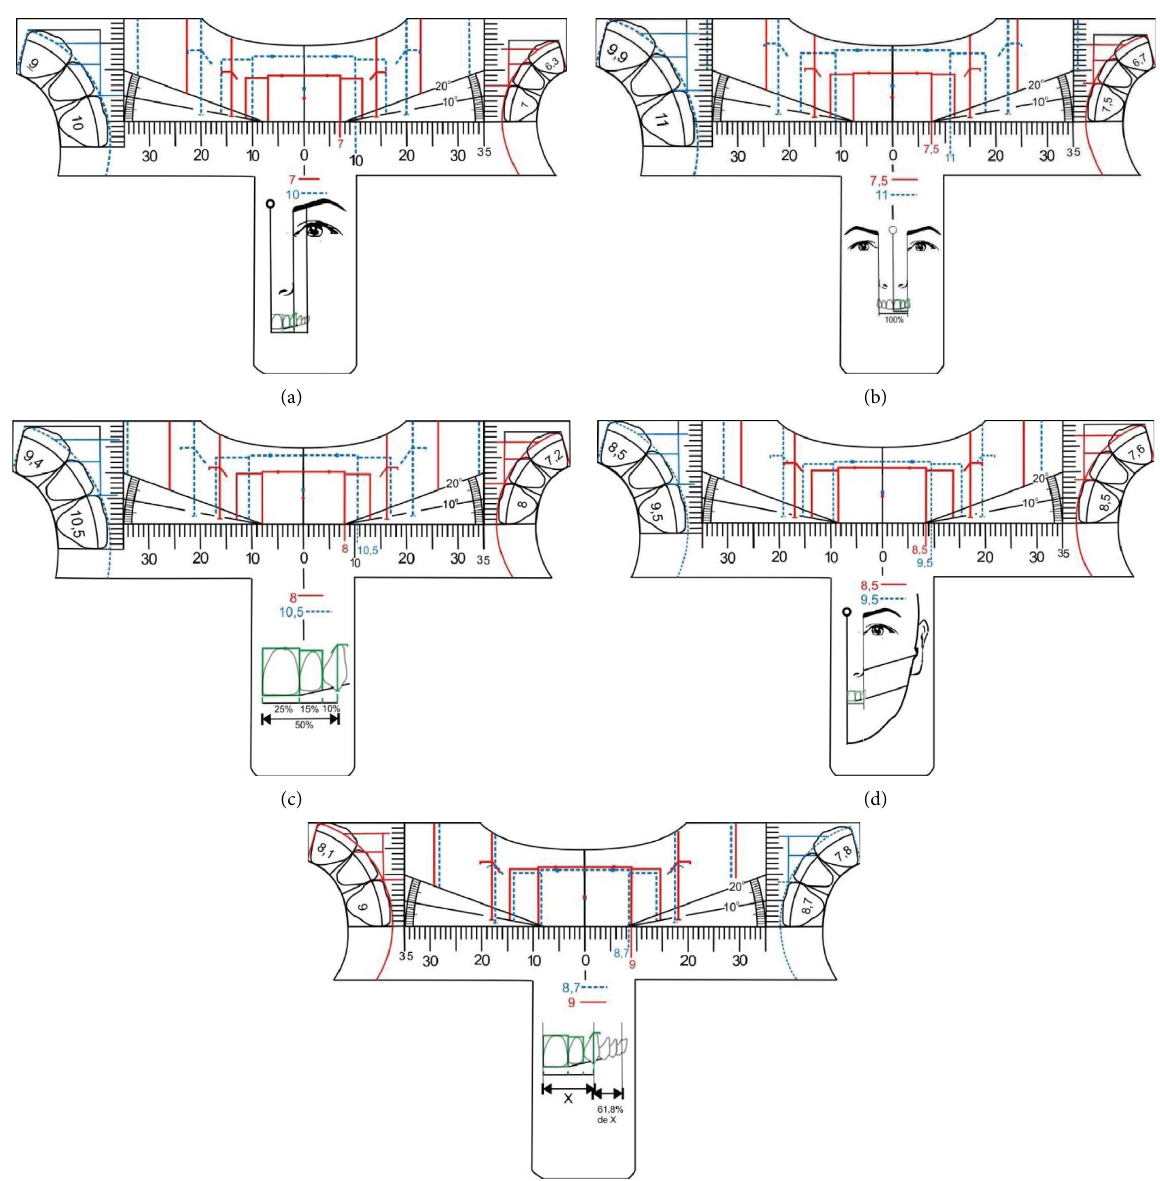
Figure 1: Frontal view illustration of the fve golden proportion analysis millimetric